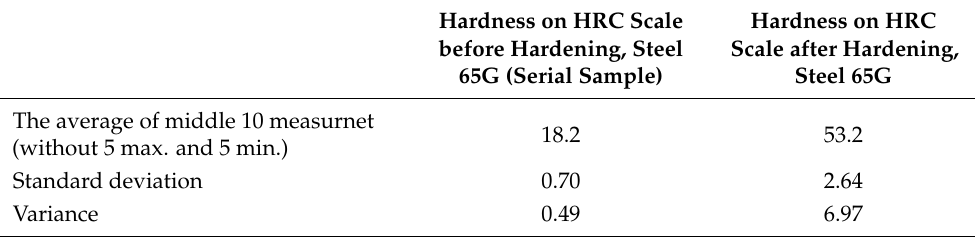
The average of middle 10 measurnet (without 5 max. and 5 min.)